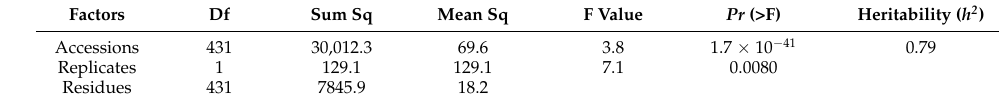
Table 1. The analysis of variance for seed germination rate after waterlogging treatment of the 432 wheat varieties.